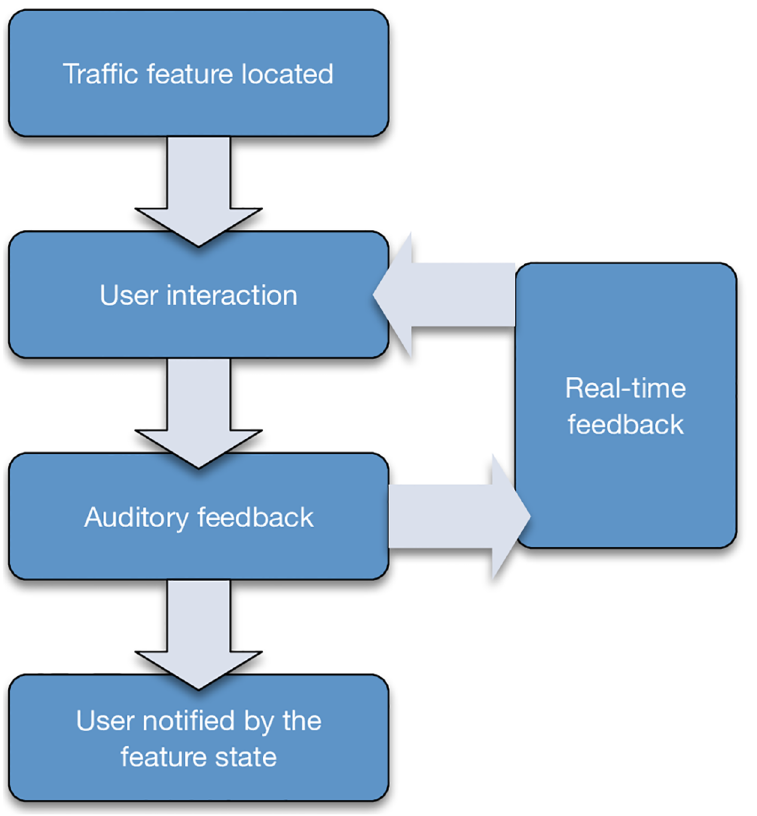
Fig 6. Interactive sonification. Model showing the interactive nature of the SoNSTAR